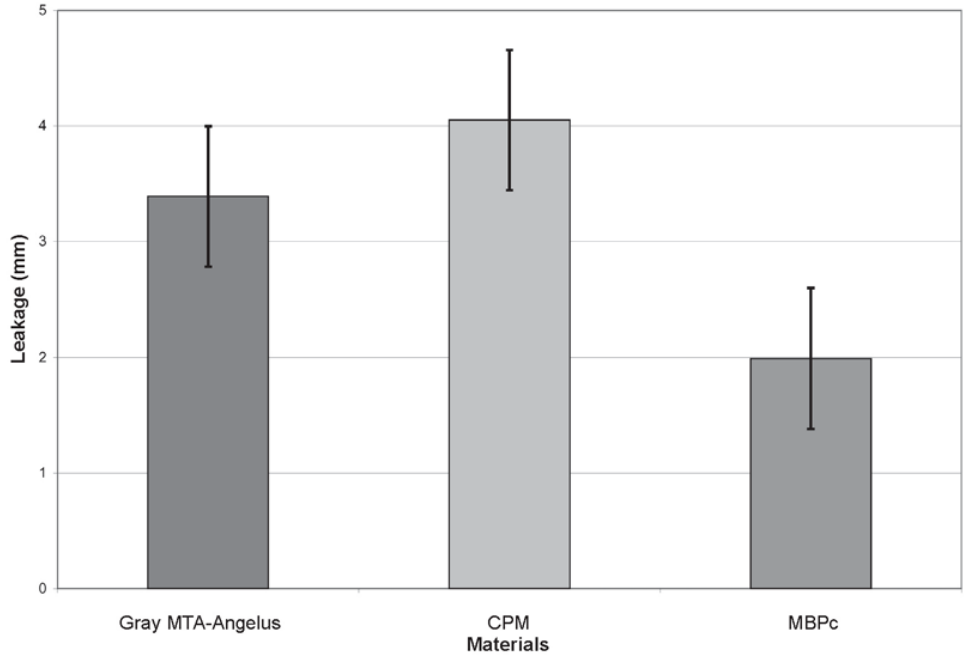
FIGURE 1- Mean leakage of 0.2% Rhodamine B, in millimeters, for the three groups receiving the apical plug. Data are mean ± SEM. (n =